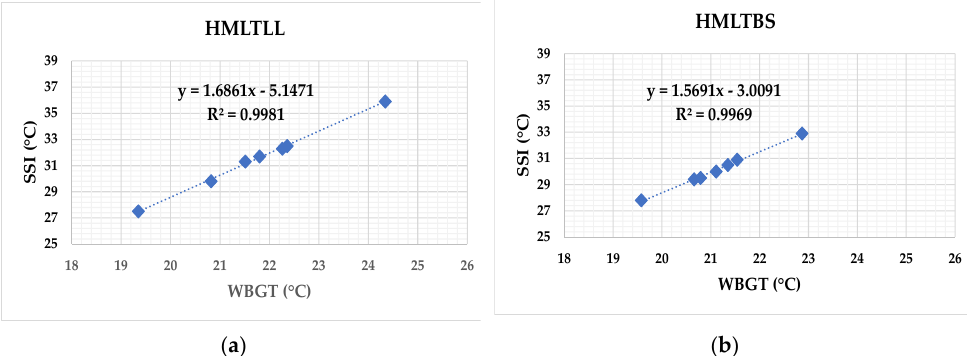
y = 1.6861x ‐ 5.1471 R² = 0.9981